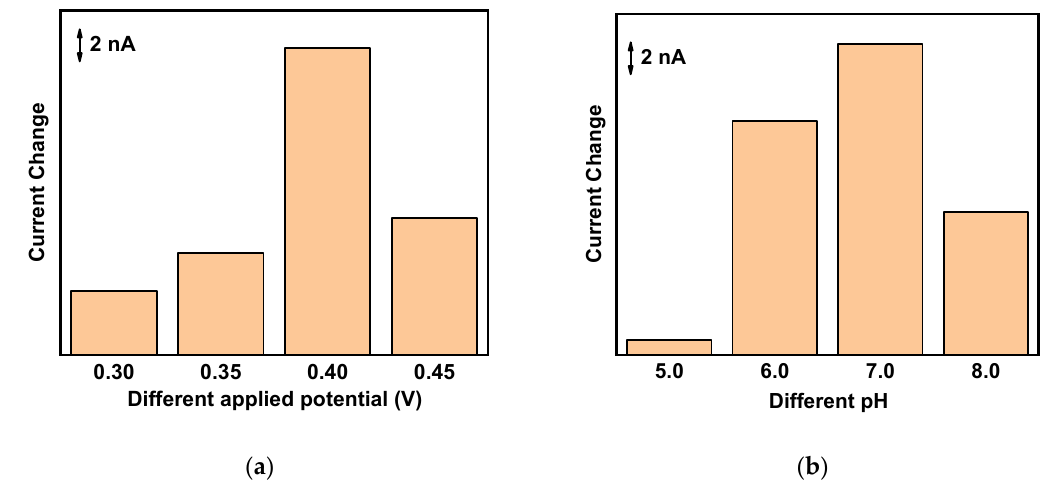
Figure 3. ( a ) Current change under different applied potential for the g ‐ C 3 N 4 nanosheets in 0.1 M PBS (pH 7.0) with the addition of 100 nM 5 ‐ HT. ( b ) Current change under different pH values for the g ‐